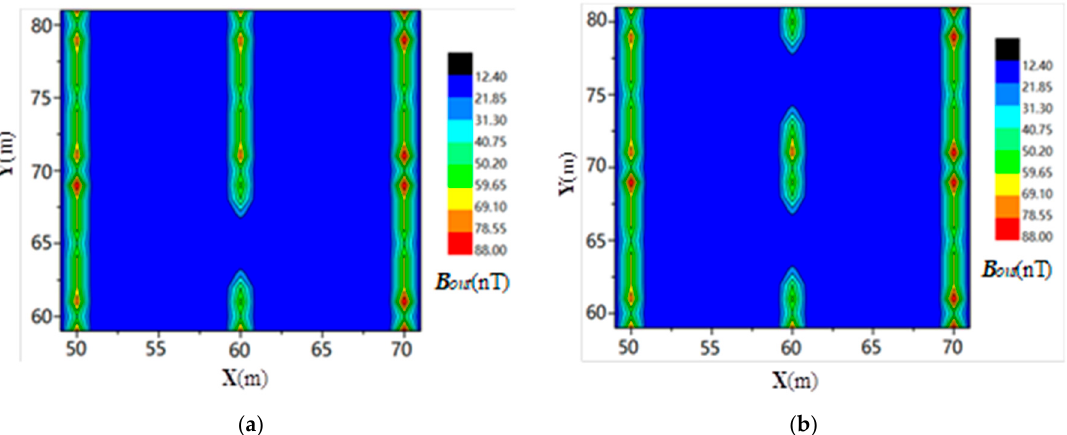
Figure 9. Measurement results from the four-coil structure method for ( a ) one breakpoint and ( b ) two breakpoints.